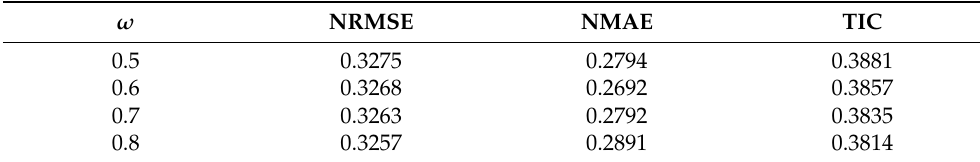
Table 5. Effect of adjusting parameter ω with the data from WF3.